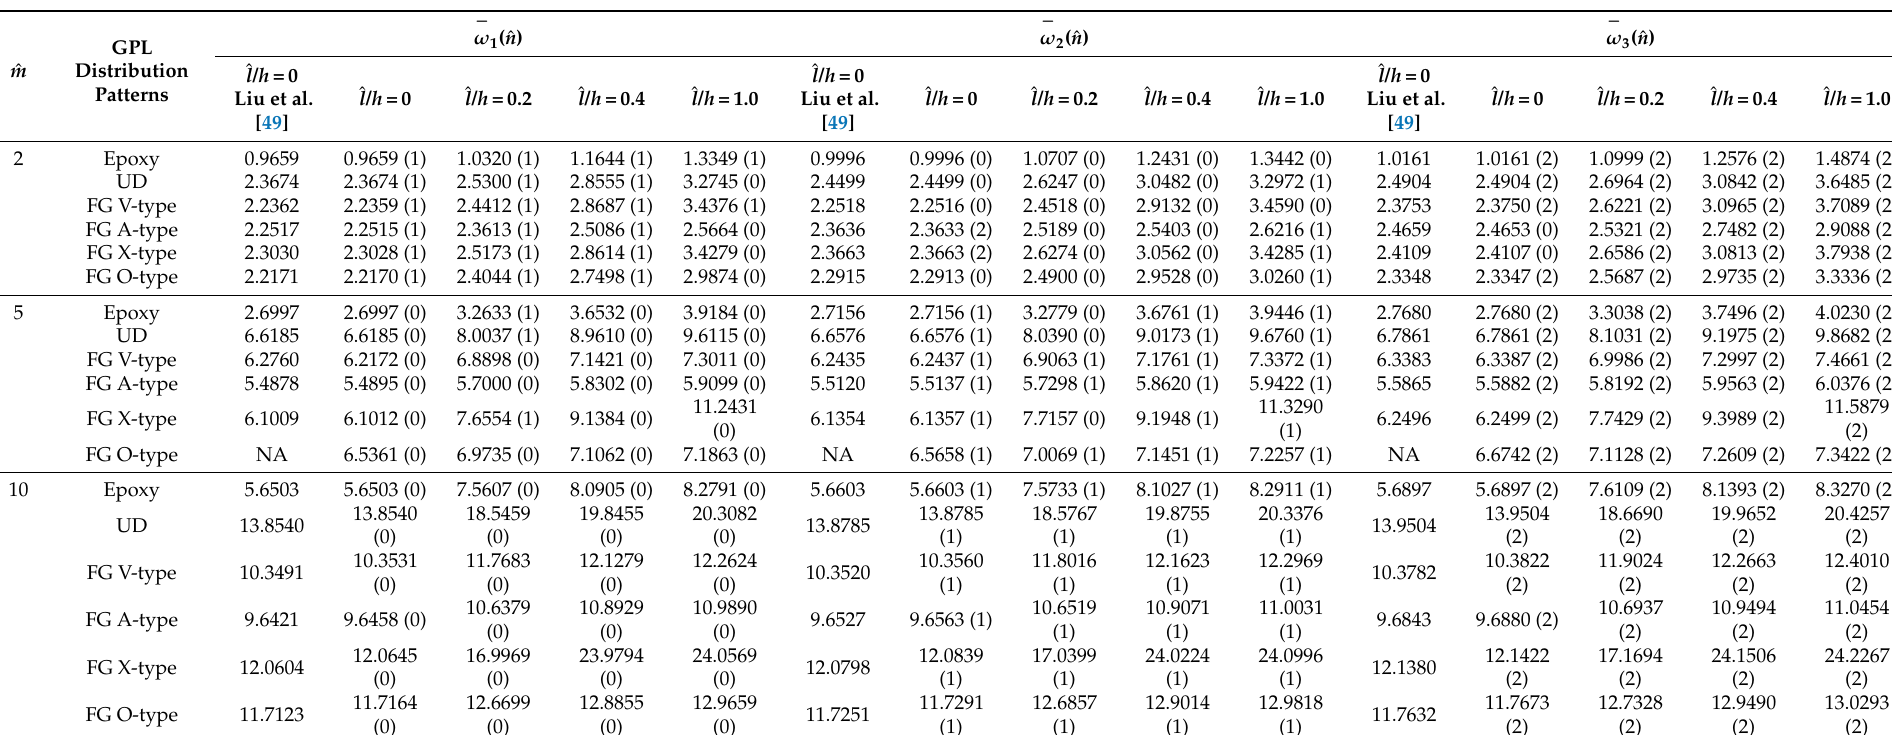
(cid:112) ρ epoxy / E epoxy